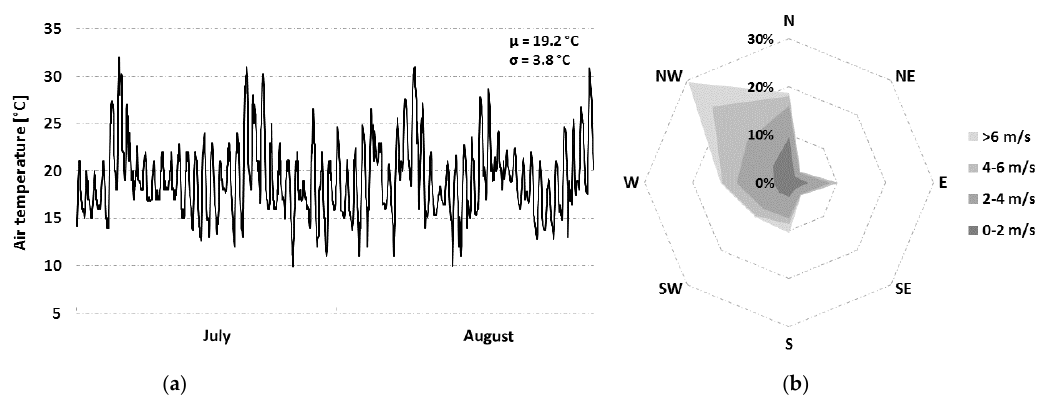
Figure 4. Hourly averaged climatic data [54]: ( a ) exterior air temperature; ( b ) wind speed and direction frequency.